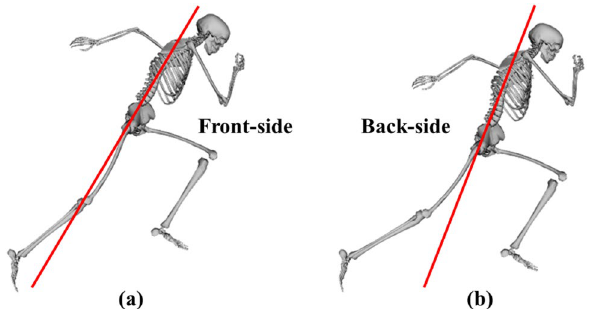
Figure 1. Front-side ( a ) and back-side ( b ) mechanics schematic during the second step stance phase of a maximal effort sprint. The solid red line drawn parallel to the torso indicates when the thigh segment is in